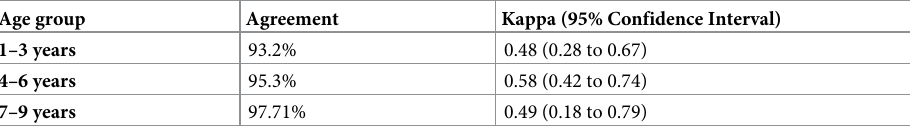
Table 4. Agreement between field and image grade for 1106 children with gradable images by age